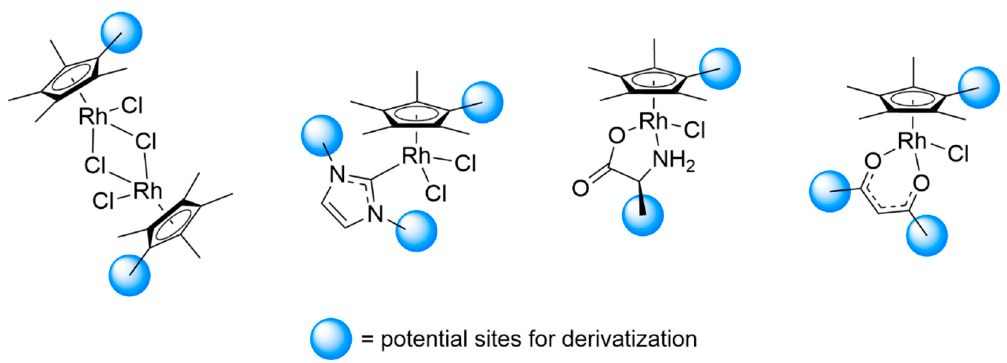
Figure 7. Parent structures of the noble organometallic complexes.